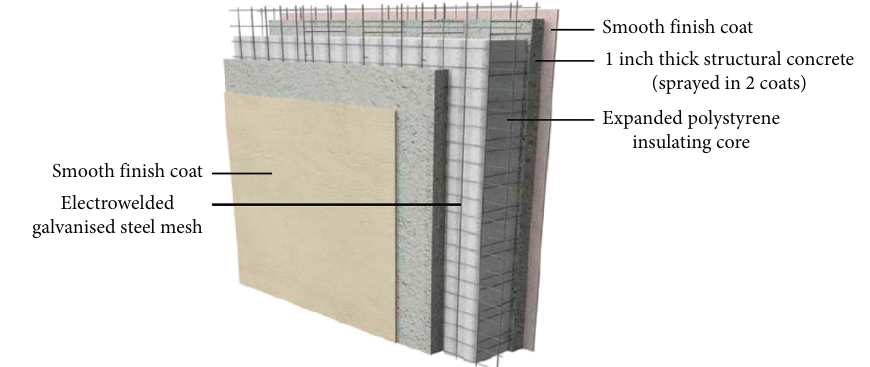
Figure 1: Typical EPS sandwich concrete wall panel (refer [6]).